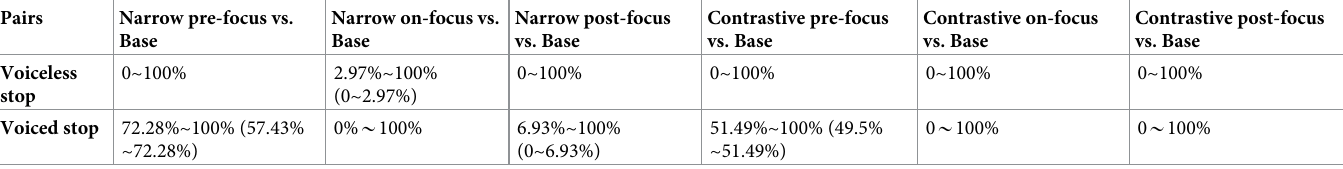
Table 3. Significantly different regions across six focus conditions and the baseline for Japanese monosyllabic targets based on functional t-tests (Marginally signifi- cant differences are marked in parentheses). Pairs Narrow pre-focus vs. Narrow on-focus vs. Narrow post-focus Contrastive pre-focus Contrastive on-focus Contrastive post-focus Base Base vs. Base vs. Base vs. Base vs.